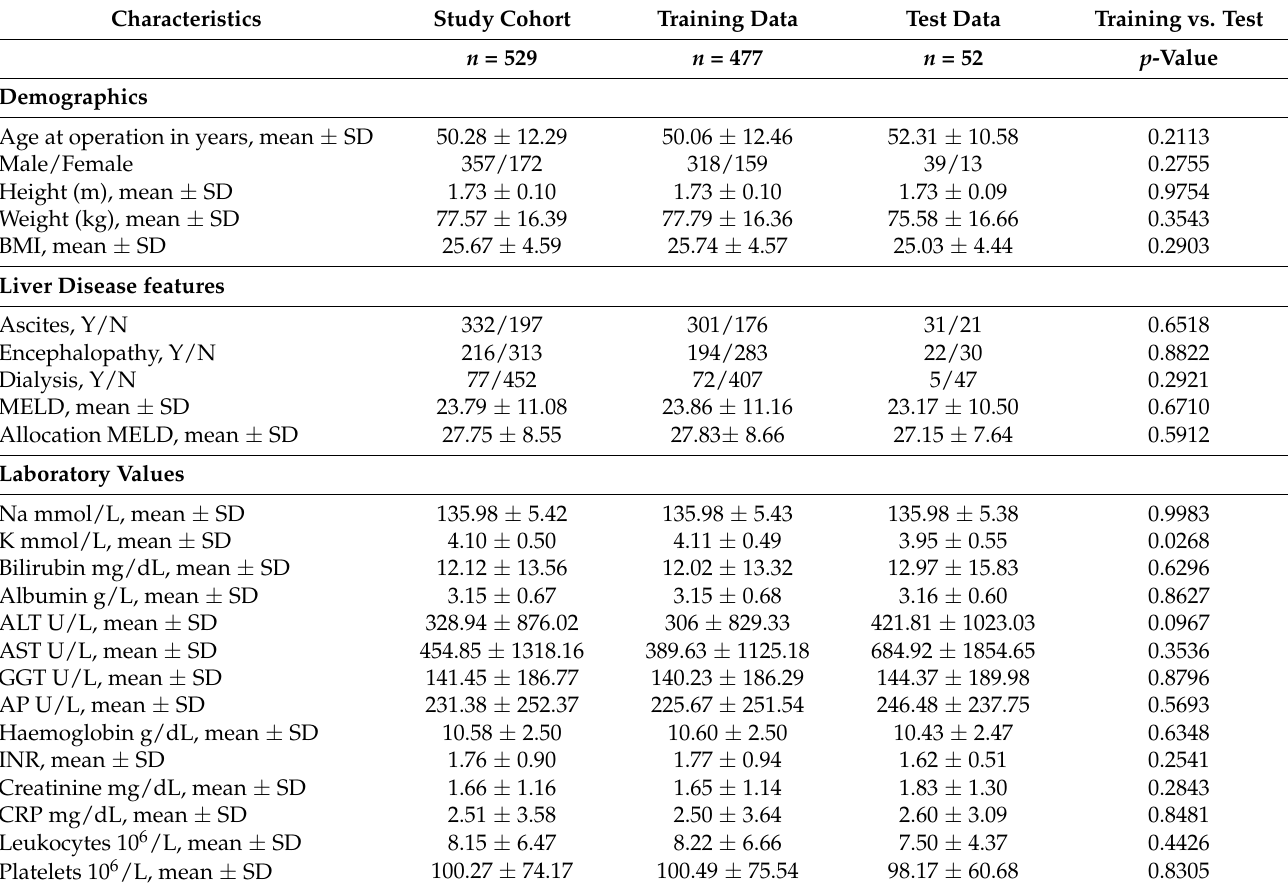
Table 1. Study data from the recipient study cohort before transplantation. Training and test data are compared.